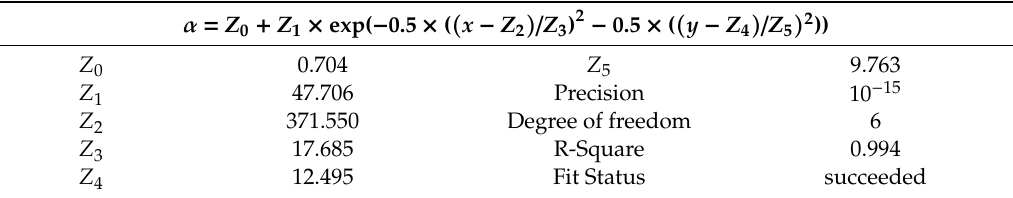
Table 4. Surface fitting equation of the amplitude-shift factors.